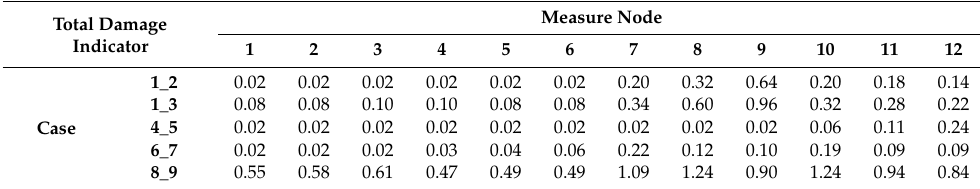
Table 4. Total damage indicators of every case using the SVR model.